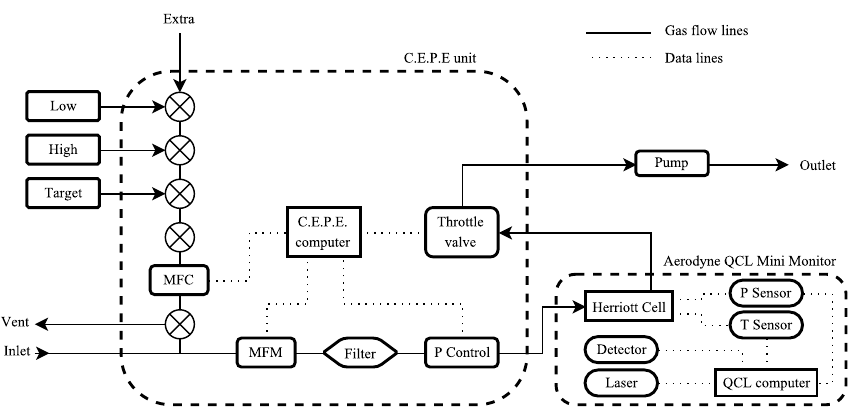
Figure 1. Schematic showing the QCLAS air sampling and data handling systems. The C.E.P.E. (calibration, exhaust, power and electronics) unit and the Aerodyne QCL mini-monitor enclosures are represented by dashed boxes around the components they contain. The calibration cylinders are labelled “low”, “high” and “target”. The flow rate of the calibration gas is controlled by the MFC (mass flow controller), and the flow rate into the instrument is monitored by the MFM (mass flow meter). The optical components associated with the alignment of the laser beam are not